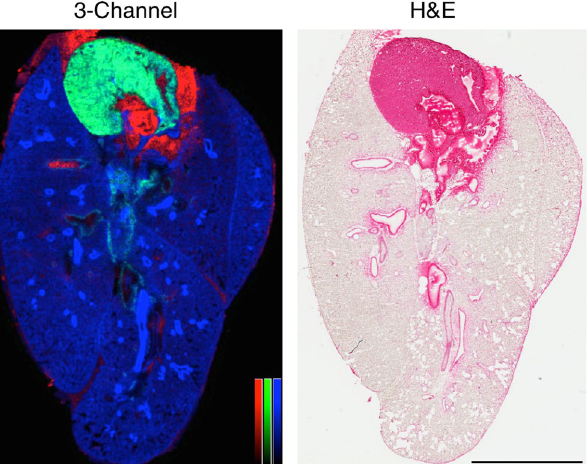
Figure 1. Gelatin inflation of the lung prior to MSI preserves overall lung histology. Mouse lung was inflated with gelatin and imaged by MALDI-TOF in negative ion mode (50 μ m spatial resolution). Left: tricolor reconstruction of heme (red, m/z 615.1), cardiolipin (green, m/z 1447.8), phosphatidylinositol [PI(38:4)-H] − (blue, m/z 885.5), normalized to TIC. Right: H&E staining of section, post-MSI. Color bars = 0–100% relative intensity. Scale bar = 5